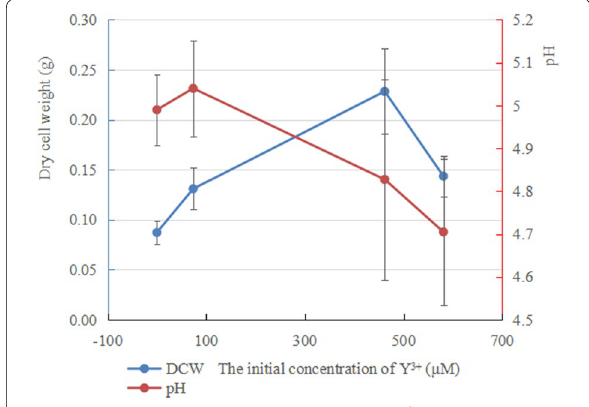
Fig. 4 The effect of different concentrations of Y 3 + on the mycelium biomass and pH of cultures